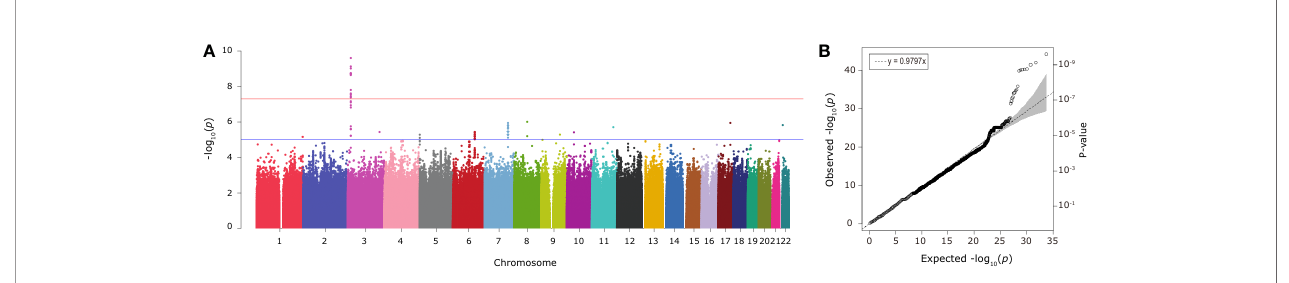
FIGURE 2 | The Manhattan (A) and QQ (B) plots from association analysis of smoking initiation (ever vs . never smokers, with men and women combined). Approximately 12 million variants were tested in the Manhattan plot. The blue and red horizontal lines on the Manhattan plot indicate the thresholds (1 x 10 − 5 and 5 x 10 − 8 , respectively). The dashed line on the QQ plot indicates the genomic in fl ation factor lambda.